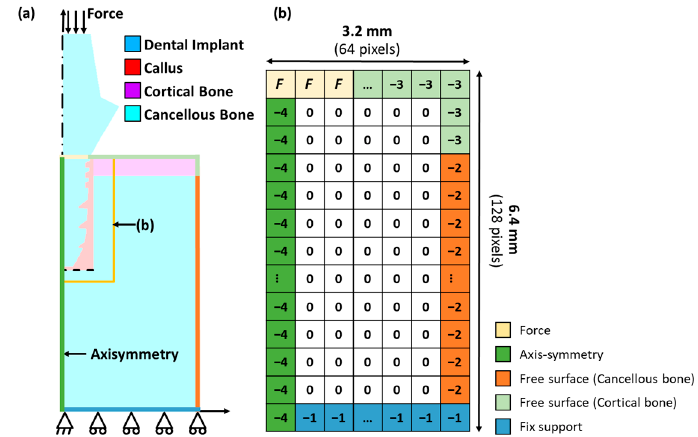
Figure A1. ( a ) Boundary conditions in the current model. The region under the load is marked in yellow; the axis–symmetry boundary is labeled in green; orange and light green are free surfaces in cancellous and cortical bone, respectively; the fixed support is labeled in blue. ( b ) Schematic of the boundary condition inputs (ˆ y ) for inputting Network 1. They are labeled in different digits, and F represents the value of the occlusal force.